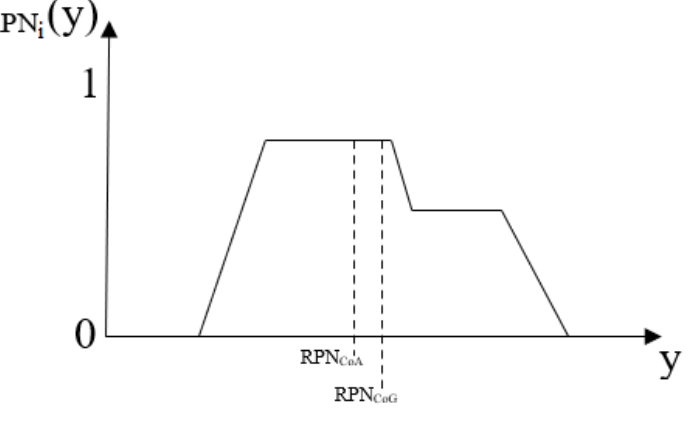
Figure 4. Defuzzification methods .